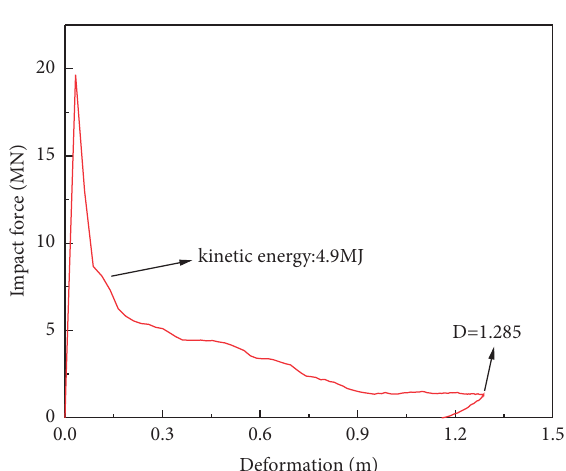
Figure 12: a − P ( a ) calculated by HPFEM.